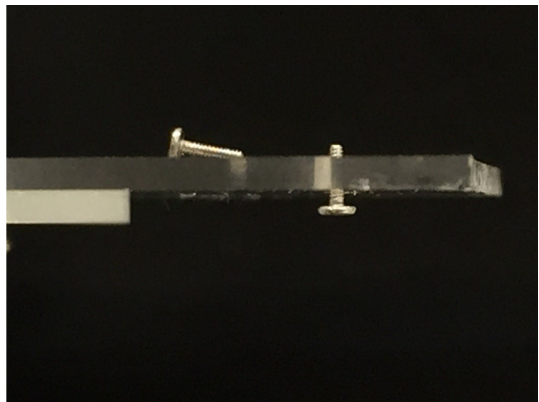
Figure 4. Joint of a S0.5 male screw (nominal length of 2 mm) to the fabricated internal